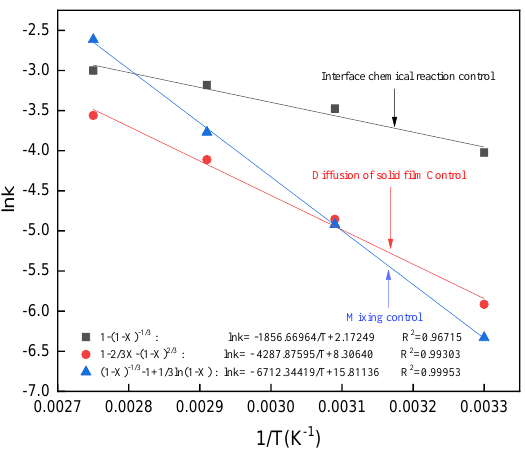
Figure 21. Curves of lnK−1/T to iron ions.